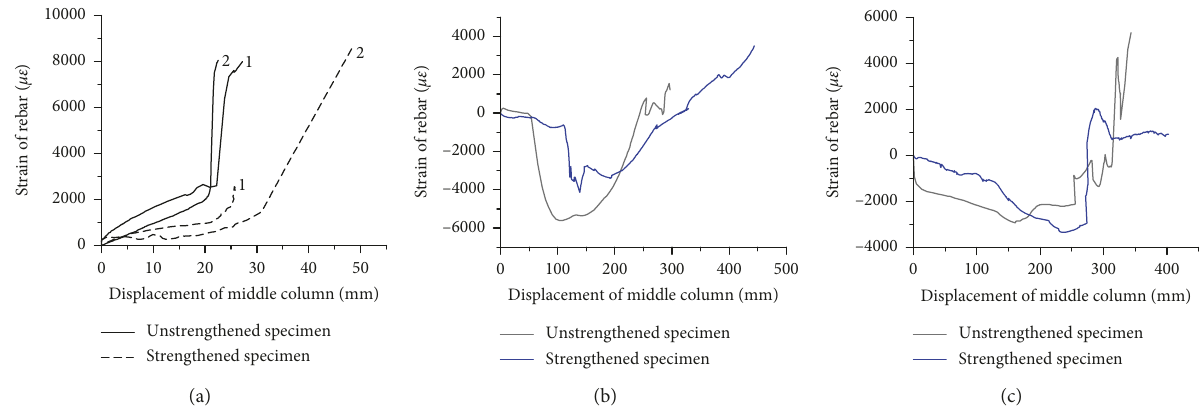
Figure 13: Strain of the longitudinal rebar on beam end sections of subassemblages. (a) Strain of (1) top rebar near side column and (2) bottom rebar near middle column. (b) Strain of bottom rebar near side column. (c) Strain of top rebar near middle column.